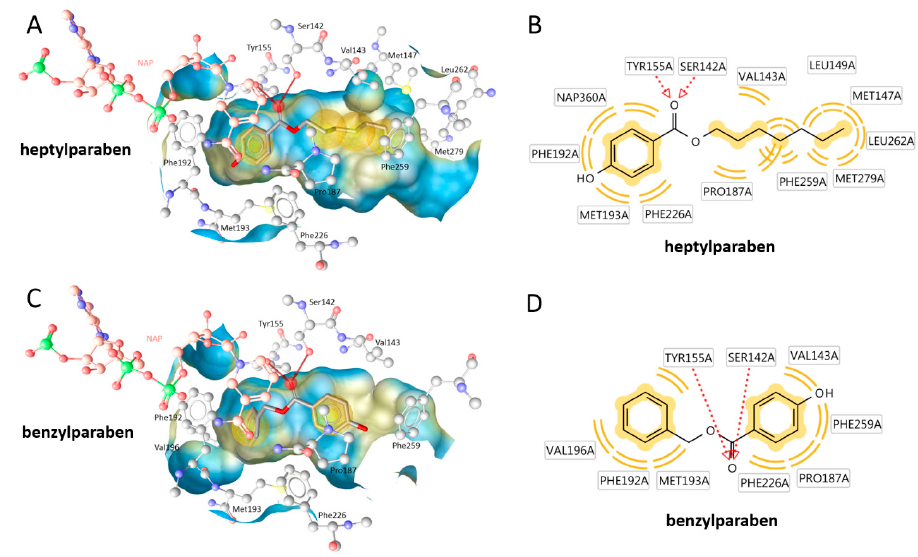
Figure 7. ( A , B ) The most active 17 β -HSD1 inhibitor heptylparaben docked into the enzymes active site. ( C , D ) Amino acids of the binding site are shown in ball-and-stick style (white—carbon, red—oxygen, blue—nitrogen, yellow—sulfur, green—phosphor). The cofactor NADP (NAP) is colored in salmon pink. The docked parabens are shown in stick style. Inhibitors with a smaller substituent, like benzylparaben, can also adopt a flipped position. Protein-ligand interactions are color-coded: red arrow: hydrogen bond acceptors; yellow sphere: hydrophobic. The ligand binding site surface is colored by aggregated hydrophilicity (blue)/hydrophobicity (yellow). Table 1. Correlation of 17 β -HSD inhibition and cLogP values of tested parabens. Compound Molecular Weight